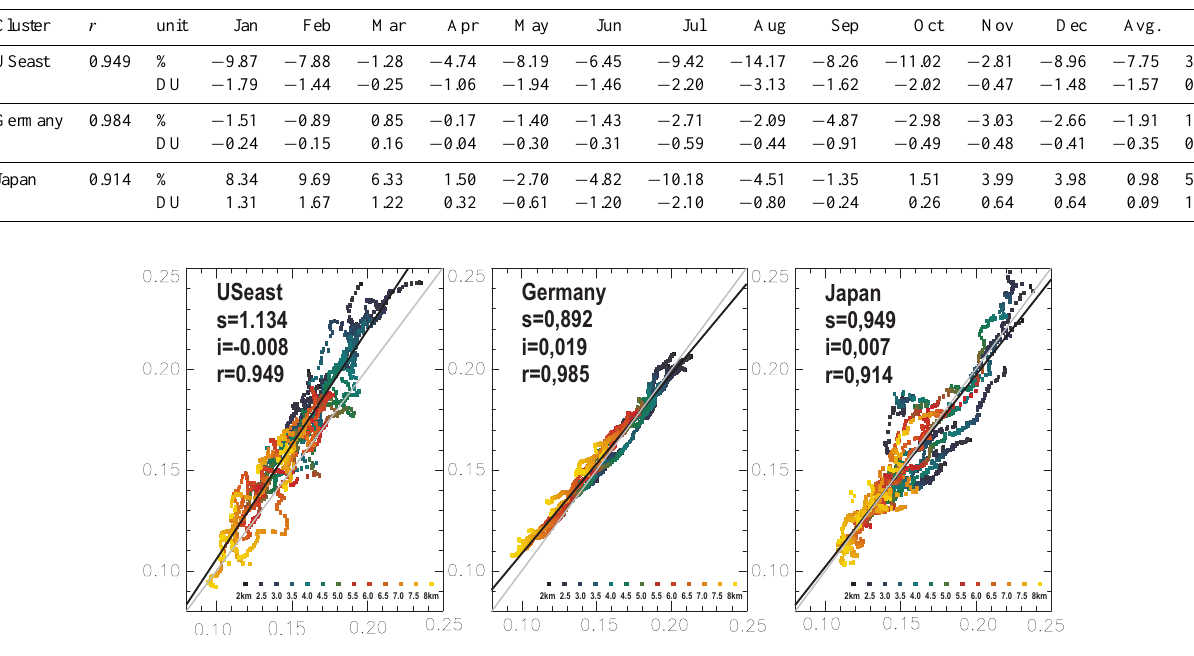
Fig. 3. Comparison of MOZAIC MPTP ( O 3 ,z,m 0 ) and WOUDC WPTP ( O 3 ,z,m 0 ) , with z between 2 and 8km in coincidence, over USeast (left), Germany (middle) and Japan (right). Measurement altitudes refer to the colour scale, from black (2km) to yellow (8km). The slope ( s ), the intercept ( i ) and the correlation coefficient ( r ) of the linear fit (black line) are given for each site with the bisector (grey line). All values are in